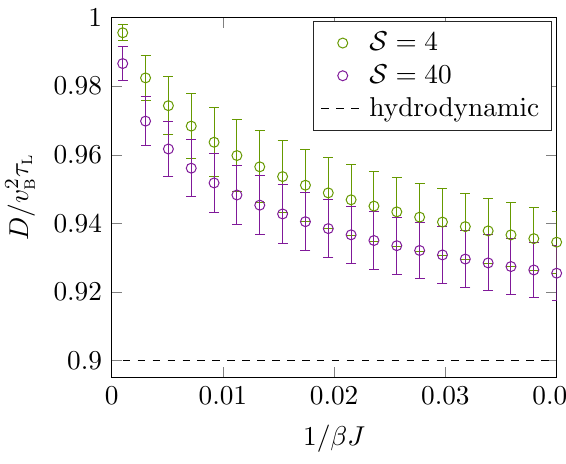
τ for ‘disordered’ periodic lattices, where L B